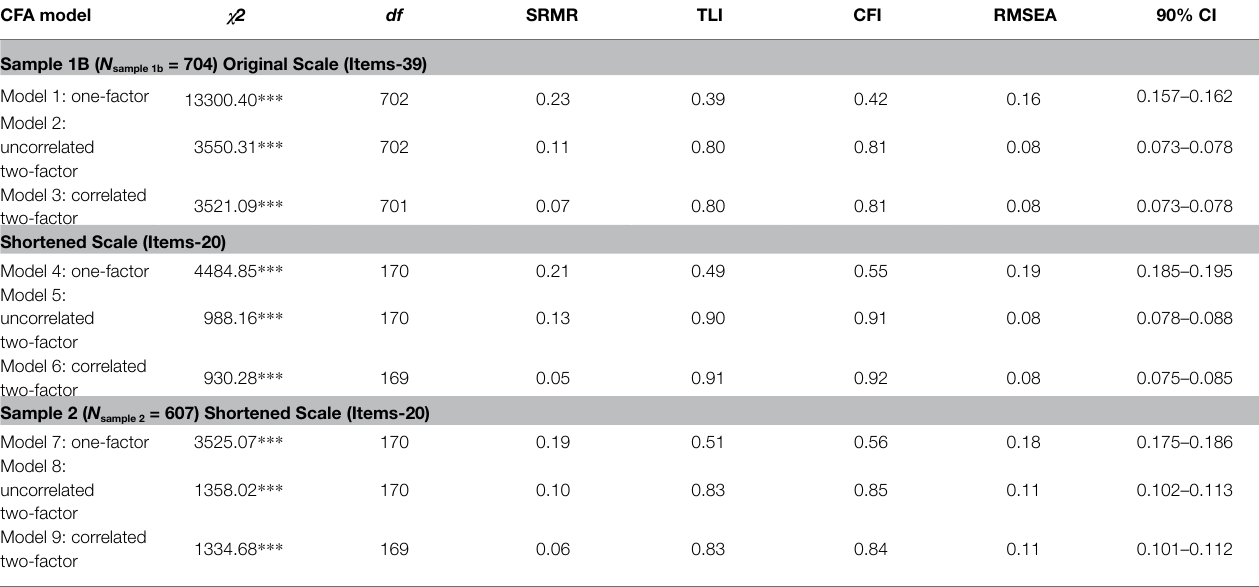
TABLE 4 | Model fit indices for the PBGECS-39 and the PBGECS-20. CFA